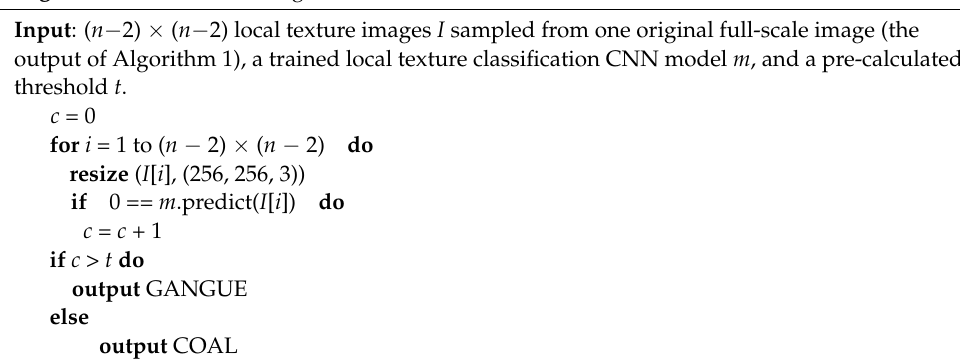
Algorithm 2. Full-scale recognition.